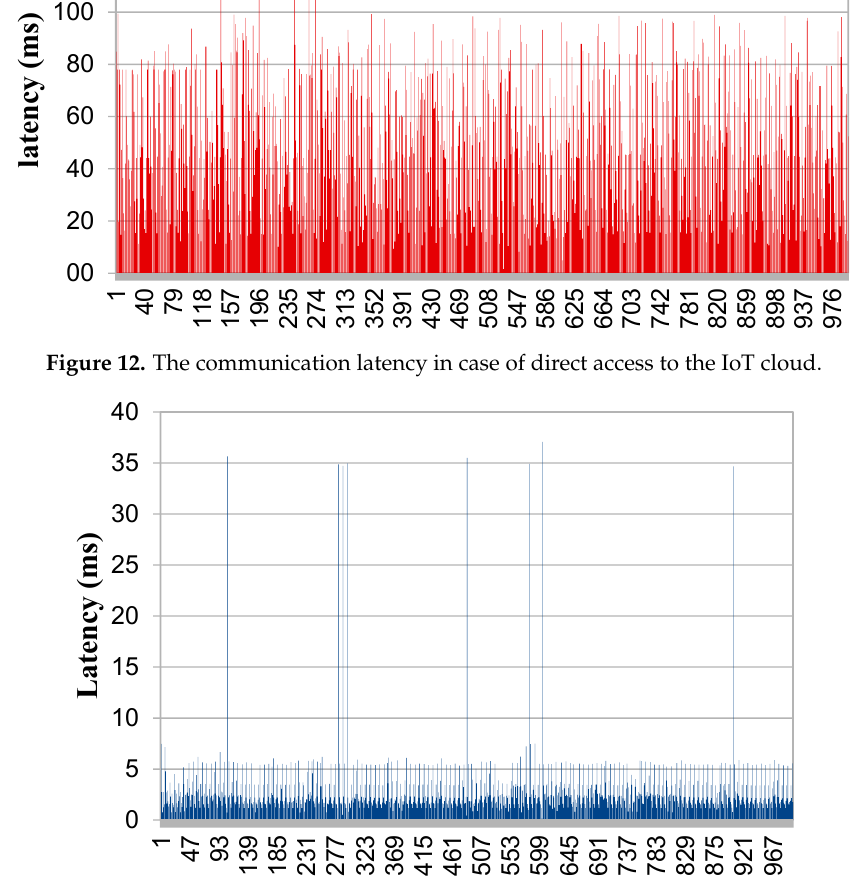
Figure 13. The communication latency for the IoT-Fog system.